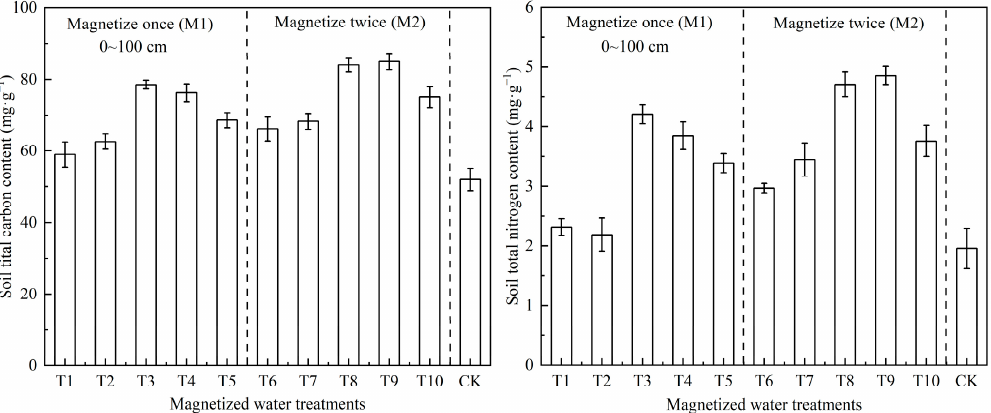
Figure 9. Effects of magnetized water irrigation treatment on total carbon and total nitrogen content in the soil root layer of